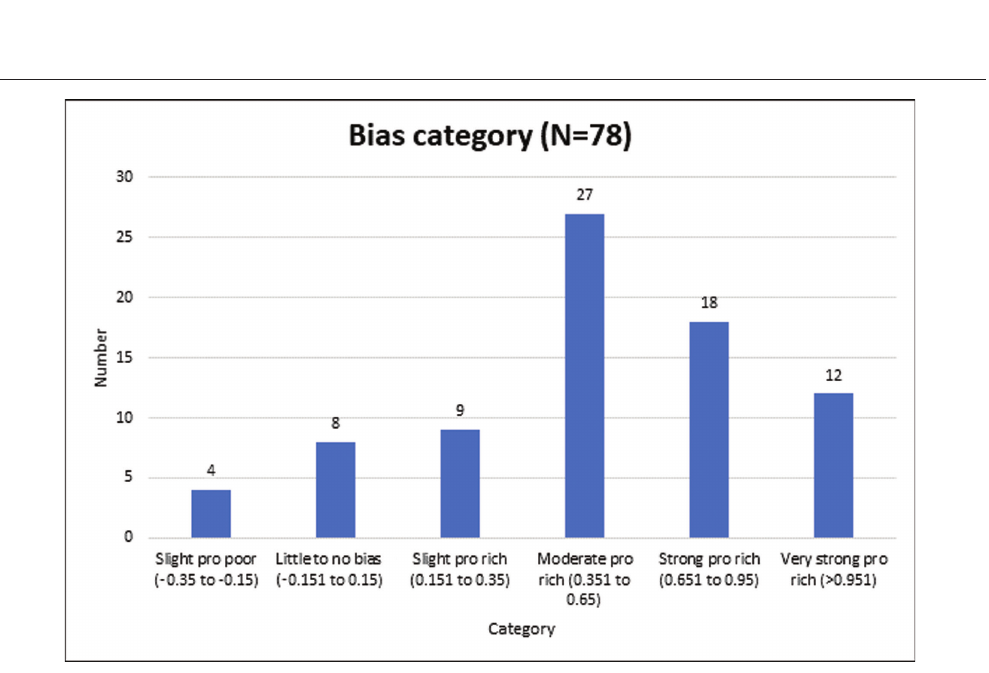
Figure 3: Number of respondents in each bias category. Categories and cut- offs were assigned according to methodology described by Harris et al. (2017a) (Source: Authors,